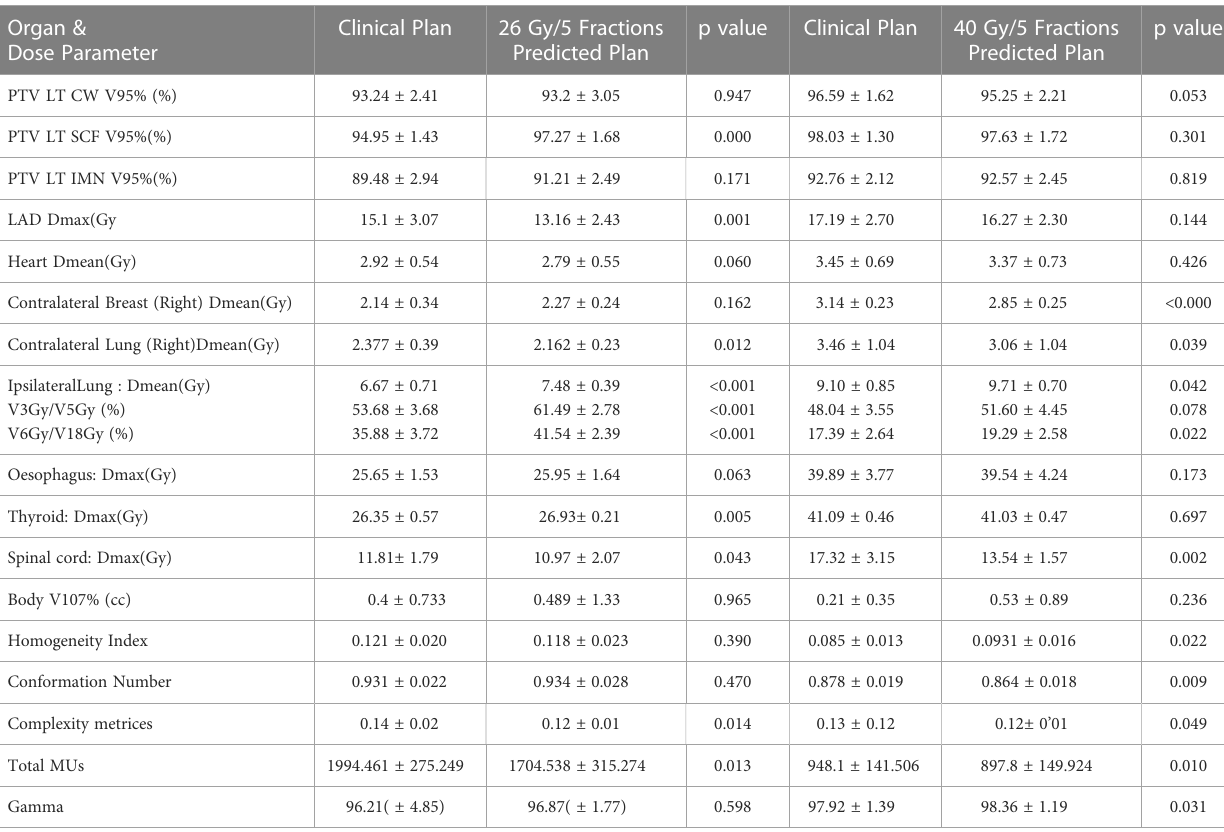
TABLE 2 Mean ± standard deviation of the dose-volume parameter of clinical plans as compared to validation plans. p values are given for Clinical plan vs Predicted plan (p<0.05 considered as signi fi cant). Organ